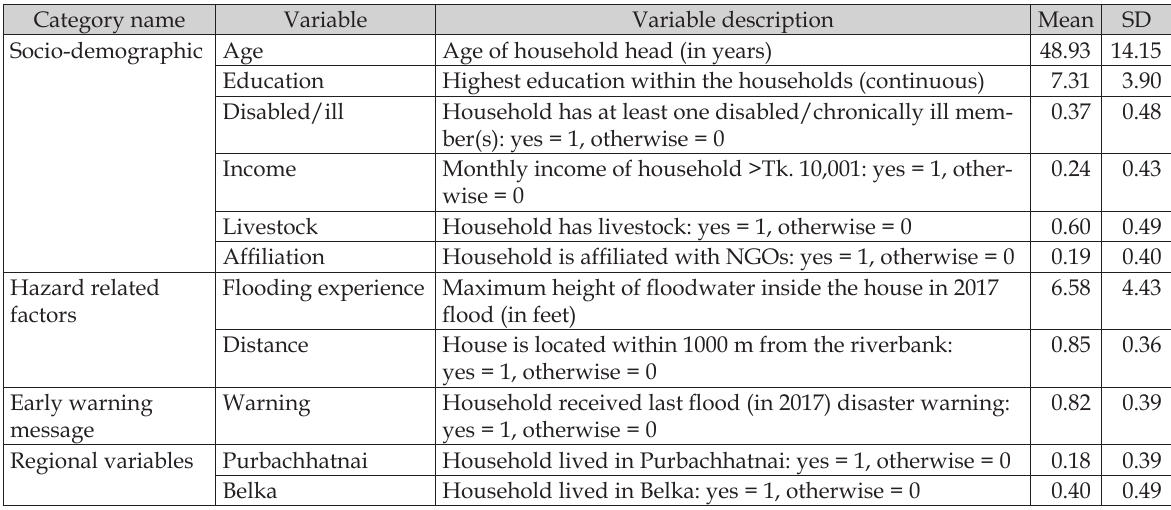
Table 3. Summary statistics of the selected variables (variables derived from questionnaire dataset,